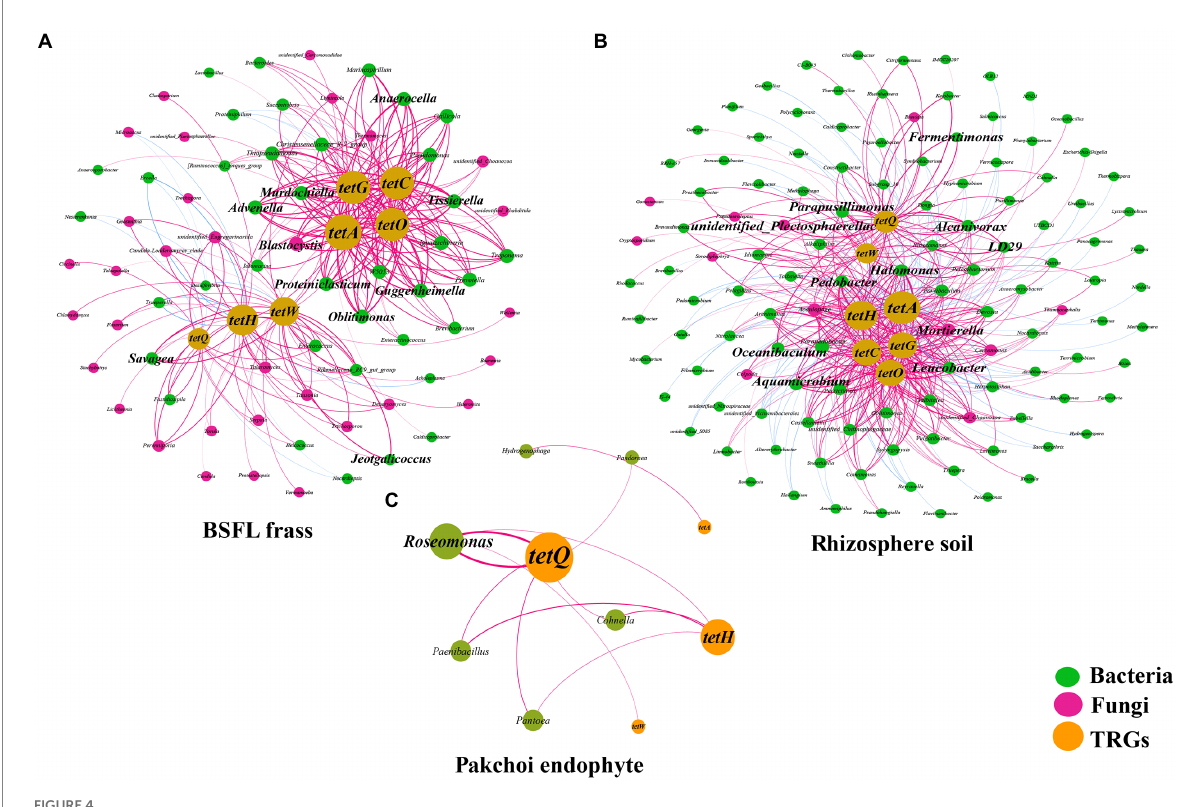
FIGURE 4 The network reveals the cooccurrence patterns between the detected TRGs and microbial taxa (genus level) in BSFL frass (A) , rhizosphere soil (B) , and pakchoi endophytes (C) . The nodes were colored according to the type of microorganism. The connection between TRGs and microorganism taxa in BSFL frass and rhizosphere soil samples represents a strong (Spearman’s correlation coefficient p > 0.8) and significant ( p value <0.01) correlation. The connection between TRGs and microorganism taxa in the pakchoi endophyte sample represents a strong (Spearman’s correlation coefficient p > 0.6) and significant ( p value <0.05) correlation. Node size is proportional to the number of connections; edge width is proportional to Spearman’s correlation coefficient